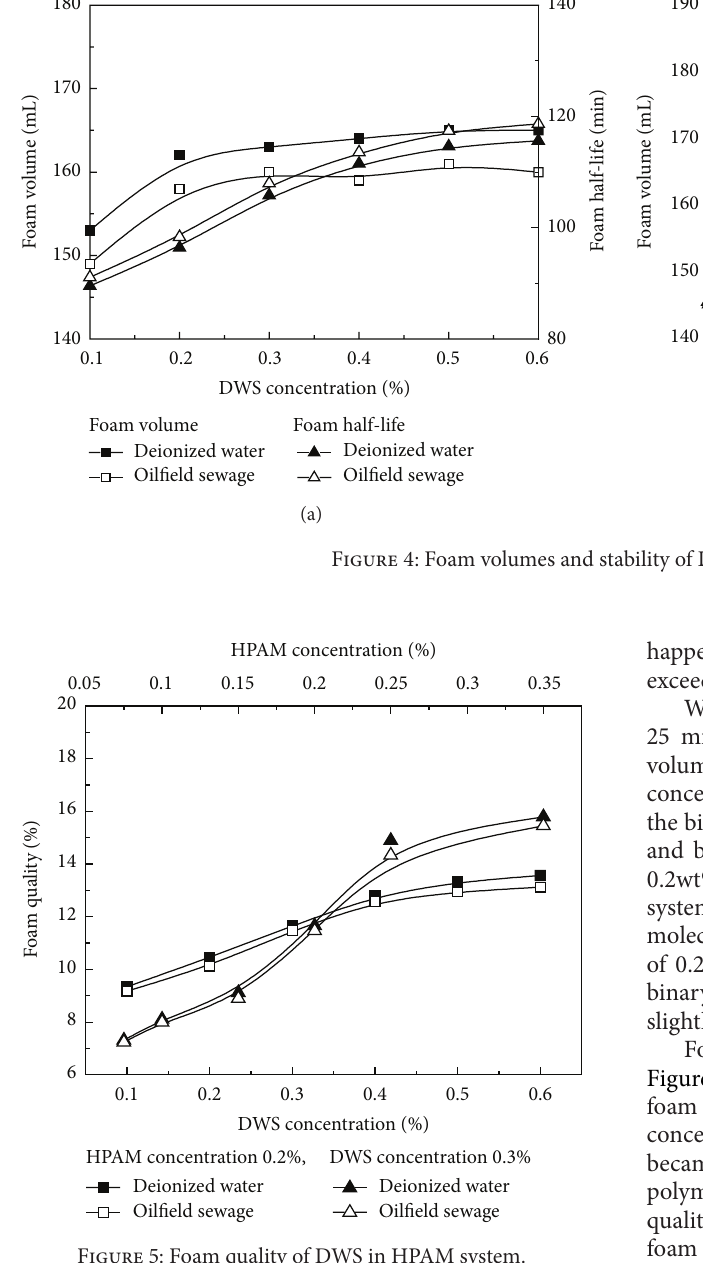
viscosities in deionized water, viscosities of the binary system reduced in